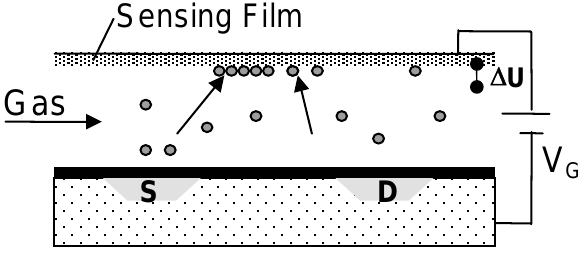
Figure 12. Scheme of a suspended gate GasFET. The gate electrode is suspended and covered with a gas sensitive layer. The electrical potential generated by gas adsorption acts as an additional gate voltage and changes the source-drain current. Reprinted from [150] with permission from